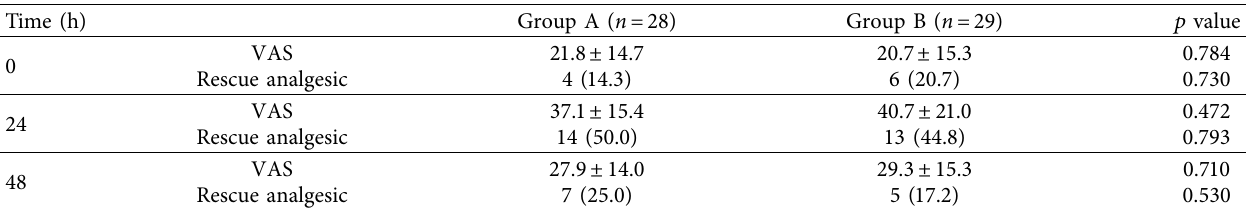
Table 2: Visual analog scale (VAS) scores and incidence of rescue analgesic at 0, 24, and 48h after